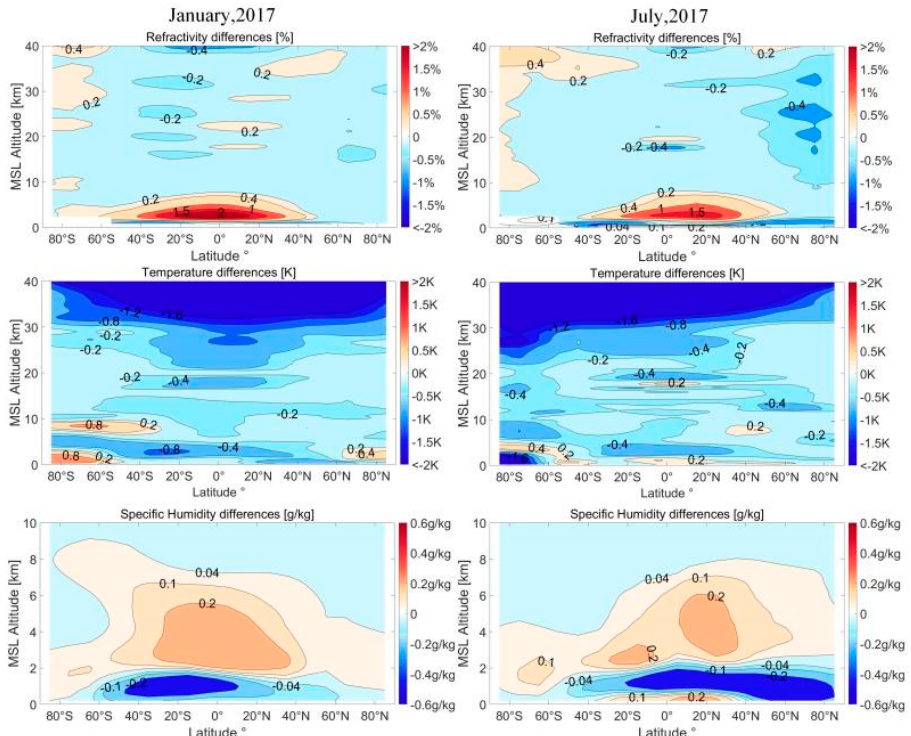
Figure 7. Latitudinal and altitudinal variations of systematic differences in refractivity (top panels), temperature (middle), and specific humidity (bottom) parameters in January and July of 2017.